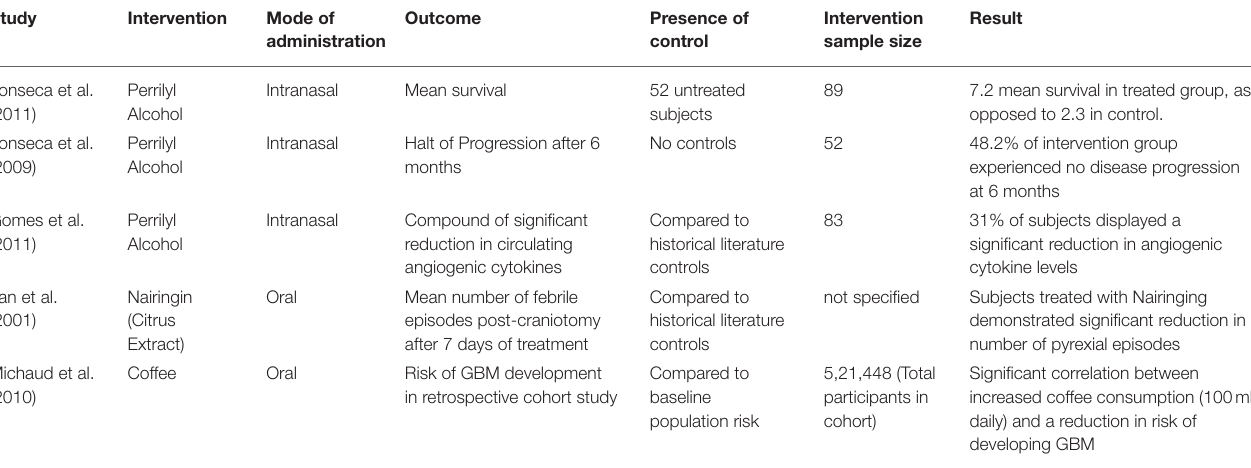
TABLE 1 | Summary of study characteristics of included articles examining human models.